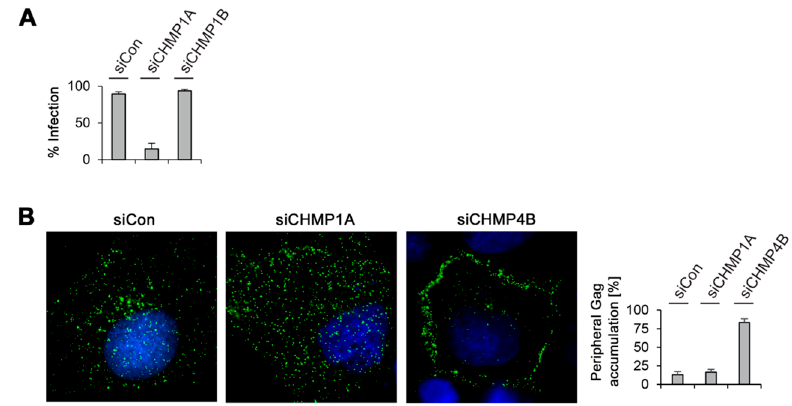
Figure 7. MLV infectivity and intracellular distribution in CHMP-knockdown cells. ( A ) Depletion of CHMP1A, but not of CHMP1B, decreased MLV infectivity. Control-, CHMP1A-,